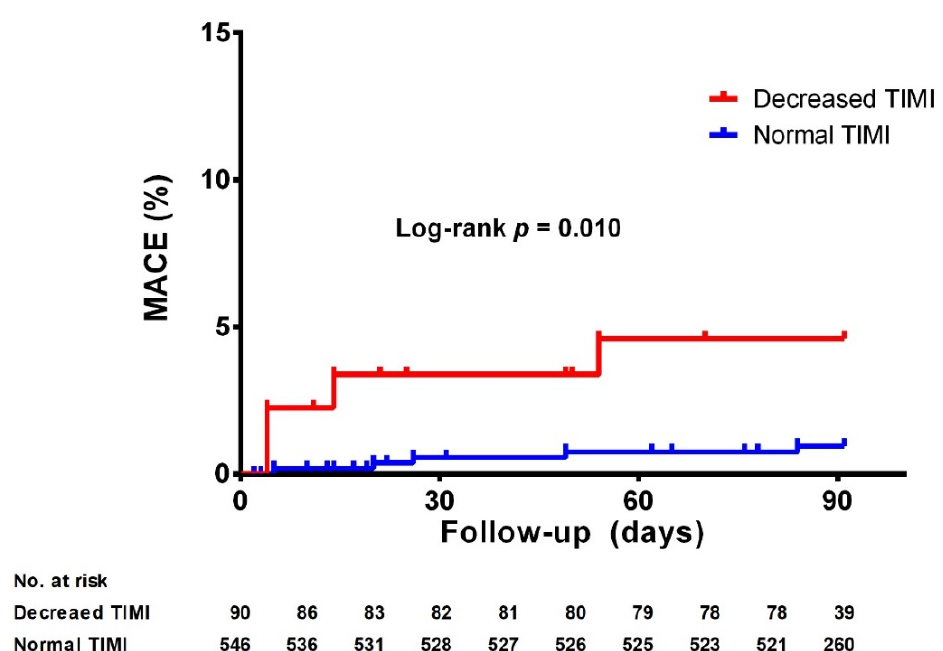
Figure 1. Kaplan–Meier curves for TIMI flow and the occurrence of major adverse cardiovascular events (MACE). Decreased post-PCI TIMI flow is associated with a significantly higher rate of MACE. TIMI, thrombolysis in myocardial infarction.